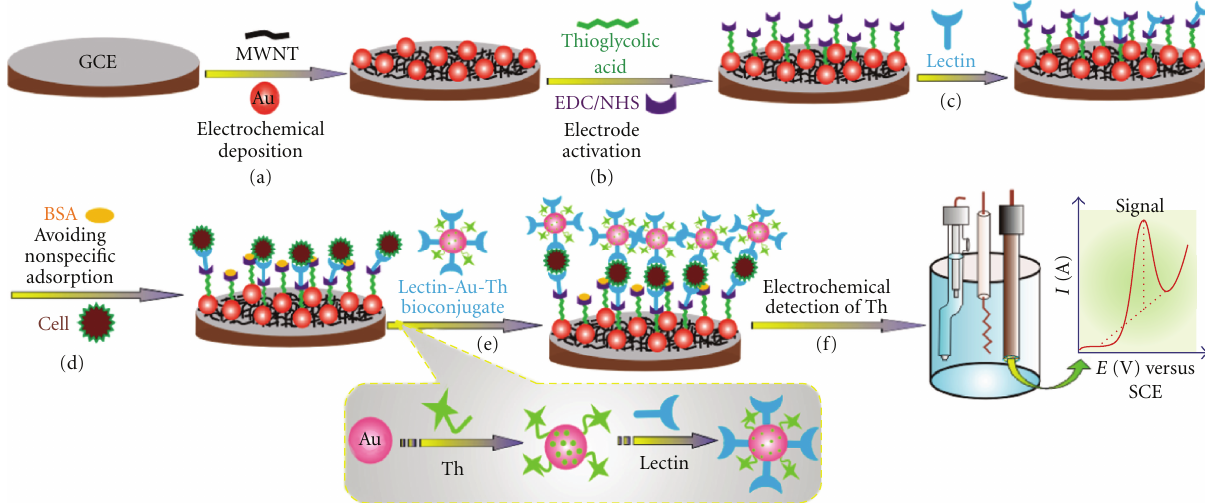
Figure 7: Schematic of the sandwich-type lectin-based sensor for electrochemical analysis of glycan expression on cells. A glassy carbon electrode was modified with gold nanoparticles, thioglycolic acid and lectins, and nonspecific adsorption to the electrode was blocked by BSA. Cell-surface glycans were bound to the lectin-modified electrode, and gold nanoparticles modified with lectins and thionine were subsequently bound to the cells to create the sandwich. Thionine was detected electrochemically by DPV. Reprinted with permission from [51]. Copyright 2010 American Chemical